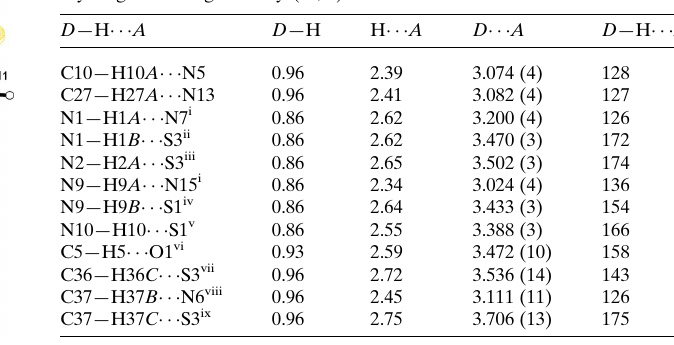
Table 1 Hydrogen-bond geometry (A˚ , (cid:3) ).